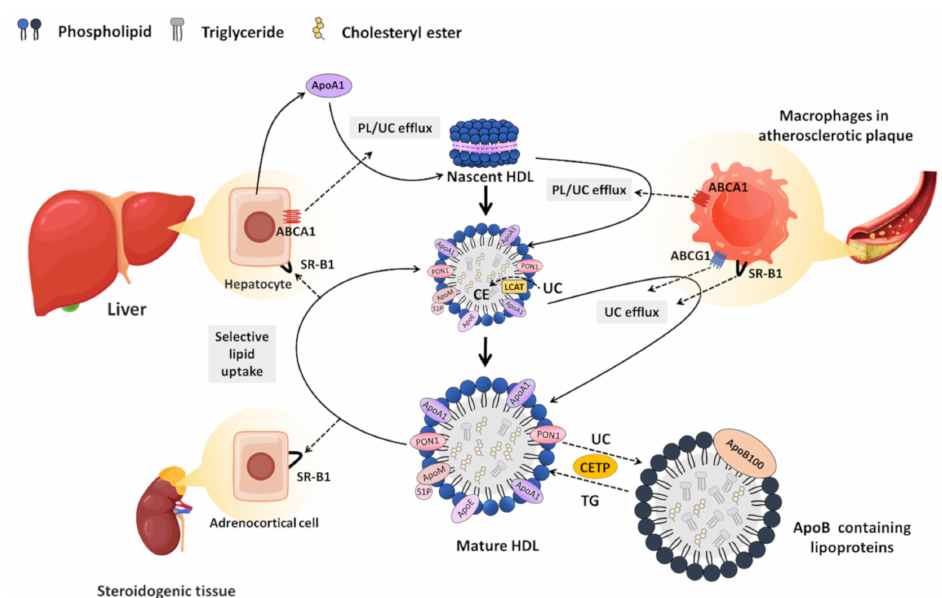
Figure 2. Biosynthesis and metabolism of HDL. The biosynthesis of HDL starts with the synthesis and secretion of apolipoprotein (Apo) A-1 as a lipid-free protein from hepatocytes. Through the efflux mediated by the transporter ATP-binding cassette transporter (ABC)-A1, ApoA1 obtains phospholipids (PL) and unesterified cholesterol (UC) from cells to form a disc-shaped nascent HDL particle. These particles take up additional PL and UC through ABCA1-mediated efflux. Lecithin:cholesterol acyltransferase (LCAT) converts UC into the more hydrophobic cholesteryl ester (CE), which is taken to the center of the HDL, shaping HDL into a spherical particle. Spherical HDL serves as an acceptor for UC efflux mediated by ABCG1 and SR-B1. Cholesteryl ester transfer protein (CETP) mediates the exchange of cholesteryl esters in HDL with triglycerides in ApoB-containing lipoproteins, reducing the HDL cholesterol levels. HDL cholesterol (UC and CE) is directly cleared in the liver via SR-B1, which mediates a process called selective lipid uptake in which the lipid moiety of HDL is taken up by cells and the lipid-depleted particle returns to the circulation. Cholesterol taken up in the liver can either be recycled into newly assembled ApoB-containing lipoproteins or can undergo net excretion into the bile. A similar SR-B1-mediated pathway of selective lipid uptake from HDL occurs in steroidogenic cells of the adrenal gland, testes, and ovary to support steroid hormone biosynthesis.Black dotted arrows represent the movement or conversion of cholesterol. Solid black arrows represent the movement or conversion of HDL